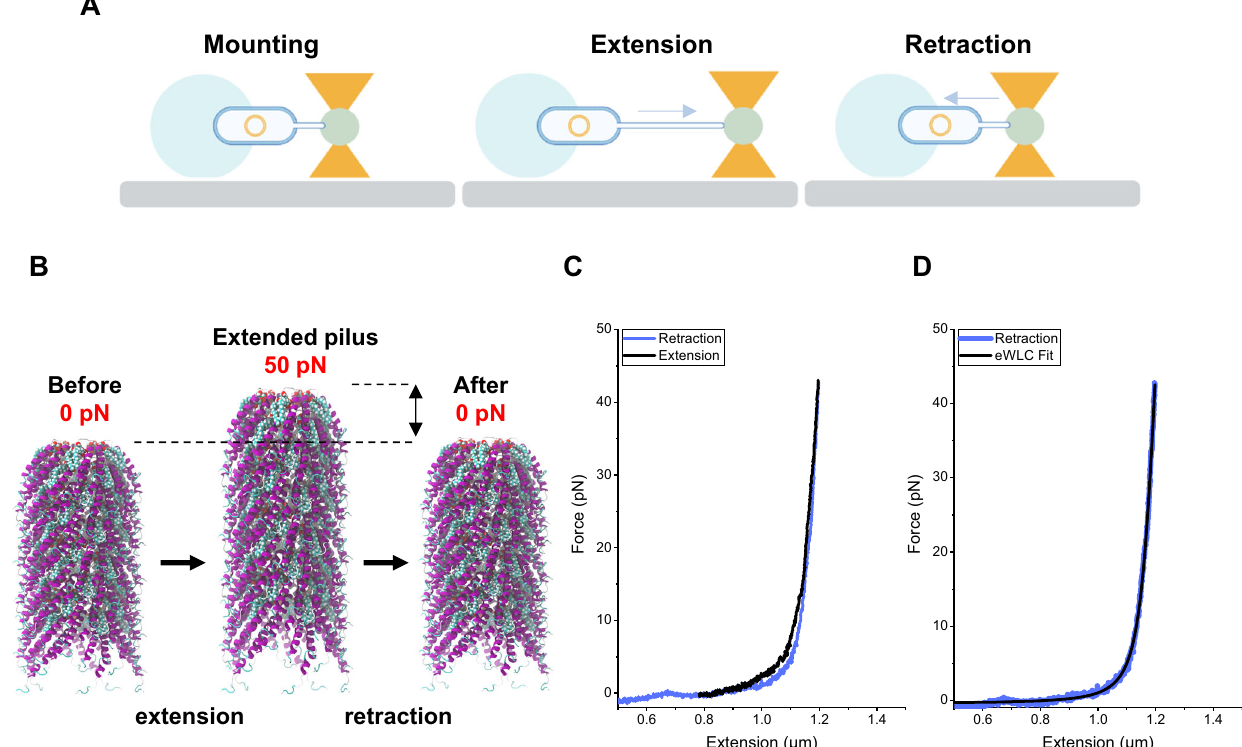
Fig. 3 | The force-extension and contraction response of F-pili fi ts the eWLC modelandshowsnohysteresis.A Overviewoftheexperimentalsetup.Abacterial cell was mounted on the stage and the F-pilus was forcefully extended and retracted to measure force response. B Graphical representation of the result. Beforetheexperimentstarts,thepilusisinarelaxedstate.Afterapplyingaforceof